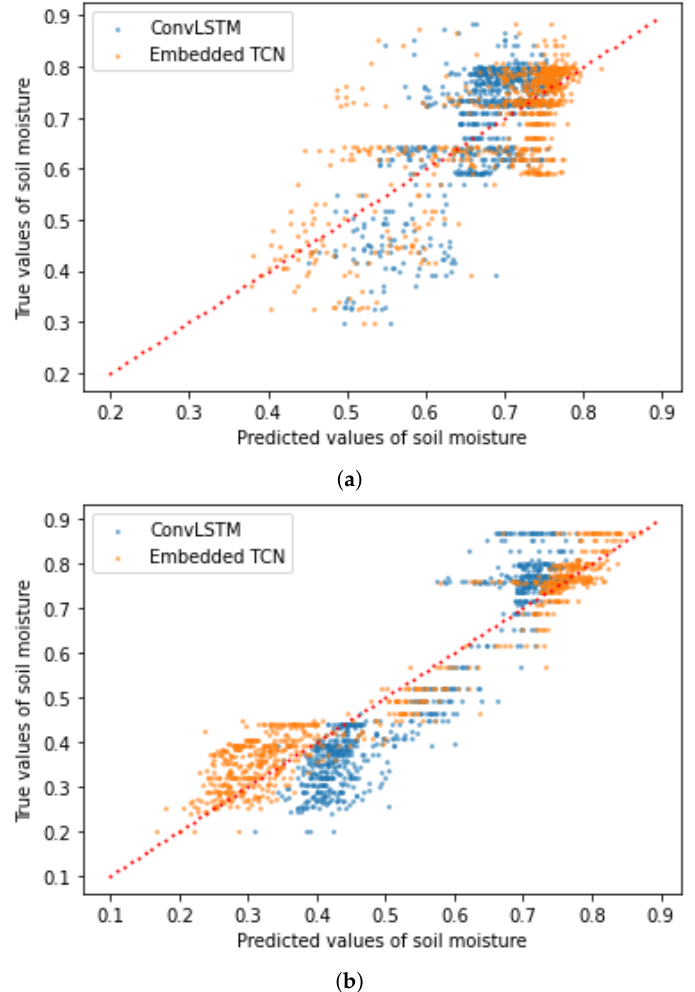
Figure 16. The true values of the soil moisture in June 2020 as a function of the predicted values when the dataset consisted of images of 28 × 28 at 1 km per pixel resolution, obtained from a region in ( a ) Idaho and ( b ) Oklahoma. ( a ) Predictions scatter plot for a region in Ihado. ( b ) Predictions scatter plot for a region in